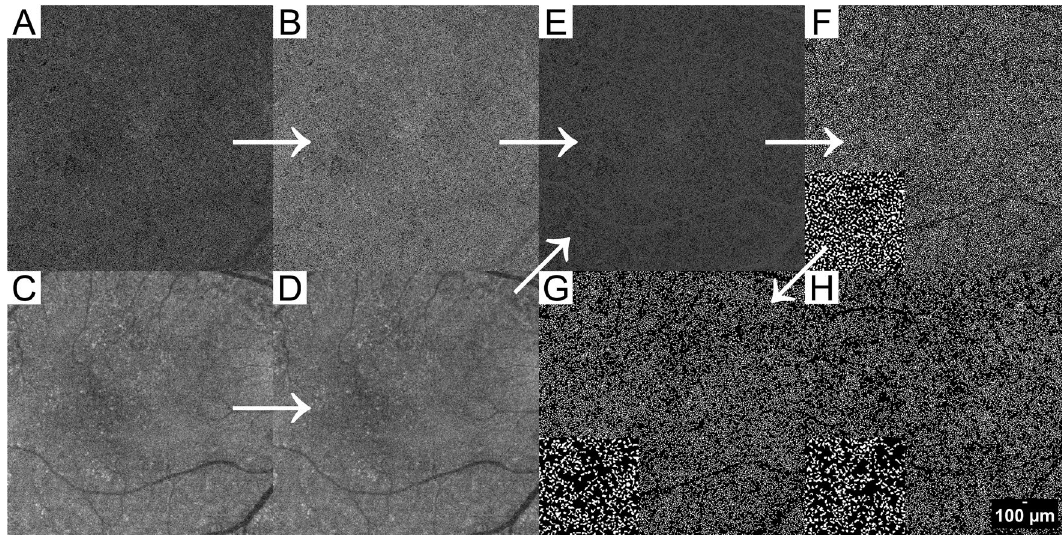
Figure 3. Demonstration of image processing protocol. A 64-year-old control eye. The white arrows demonstrate our image process protocol. ( A , C ) Original angiography image and a corresponded structural OCT image were exported from the SS-OCT machine. ( B , D ) Images after normalization and resizing. ( E ) After enhancement, the shadows of superficial vessels have been eliminated. ( F ) An FV image after binarization. White parts represent the FV and signal noise. Composition: 1 mm 2 in the center of the image. The FV was incorrectly connected into clusters because of the signal noise. ( G ) Result after removing the noise. Composition: 1 mm 2 in the center of the image. The FV was divided into reasonable sizes. ( H ) A 66 year old PCV fellow eye with CVH, showed sparse FV. Composition: 1 mm 2 in the center of the image. FV choriocapillaris flow void, CVH choroidal vascular